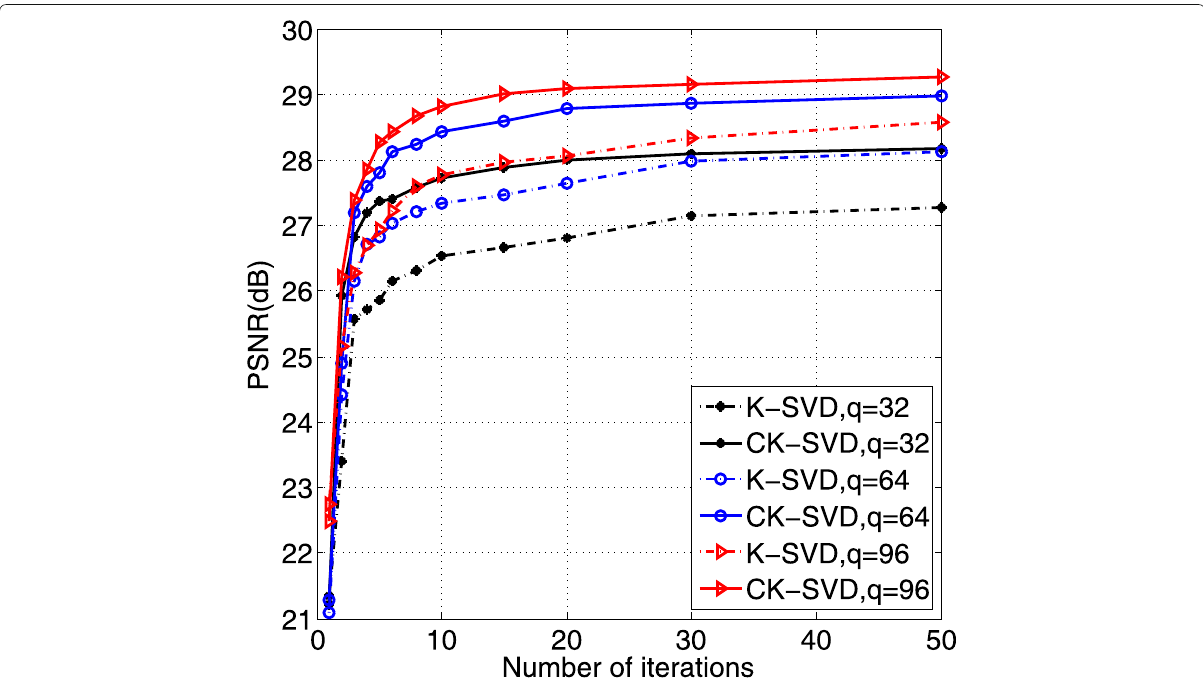
Fig. 5 PSNR of the sparse representations of test images versus the number of iterations, k = 2